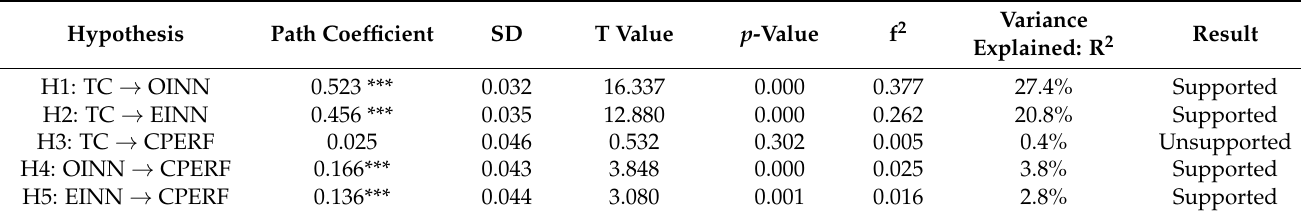
Table 6. Hypothesis test results.